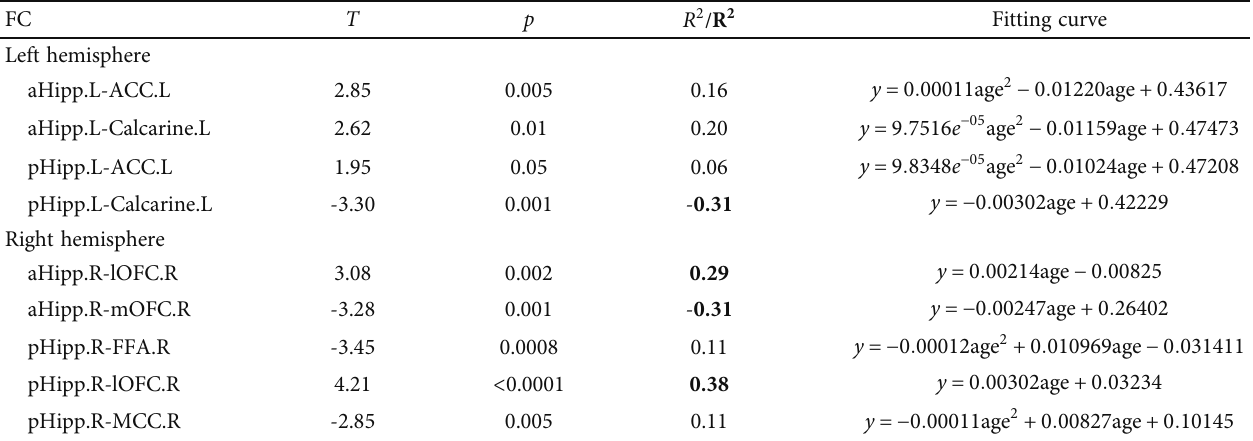
Table 3: Results of multiple regression analyses between FC and age.